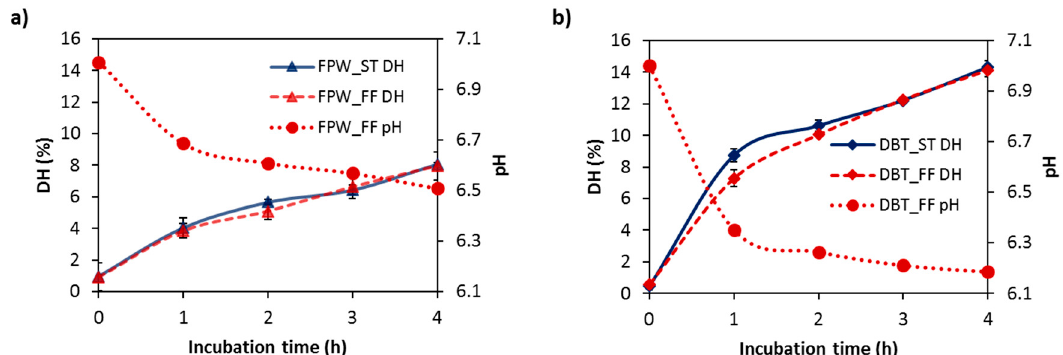
Figure 1. Degree of hydrolysis (DH) and pH profiles as a function of incubation time at 50 °C during the hydrolysis of whey protein concentrate using ( a ) FlavorPro Whey (FPW) and ( b ) Debitrase (DBT) under pH- and non pH-controlled conditions (ST and FF, respectively).